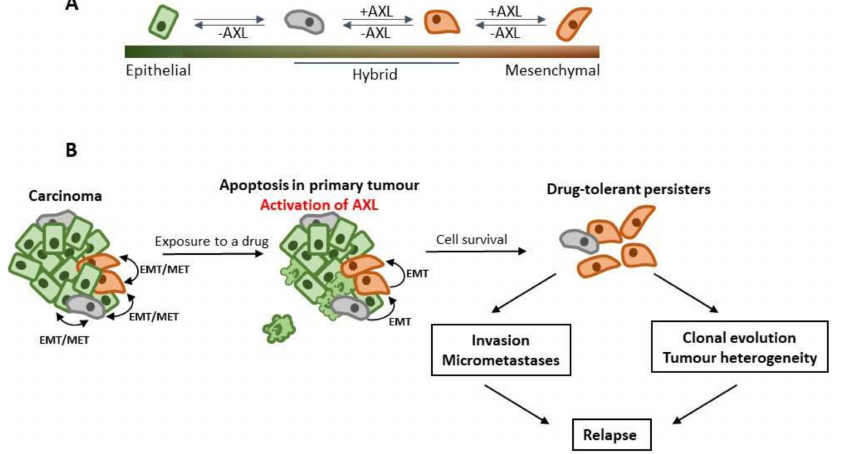
Figure 2. AXL pathway promotes drug resistance and metastasis in carcinoma. ( A ) Reversible EMT states of tumour cells in carcinomas. Transient activation of AXL signaling shifts the balance towards the mesenchymal end of the spectrum. ( B ) Therapeutic intervention results in apoptosis in a bulk of a tumour leading to PtdSer externalization and activation of AXL pathway in a proportion of tumour cells. By activating cell survival and EMT pathways, AXL stimulates the formation of invasive and drug resistant cells (drug tolerant persisters, DTPs). DTPs represent the source for the genetic evolution of cancer, cancer relapse, and